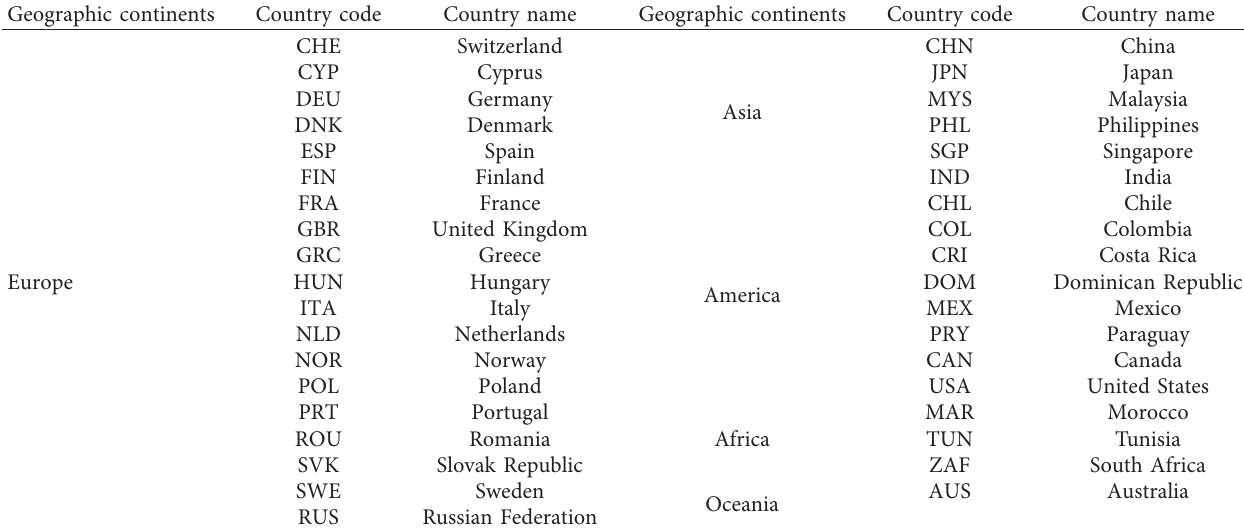
Table 2: Countries participating in the analysis.